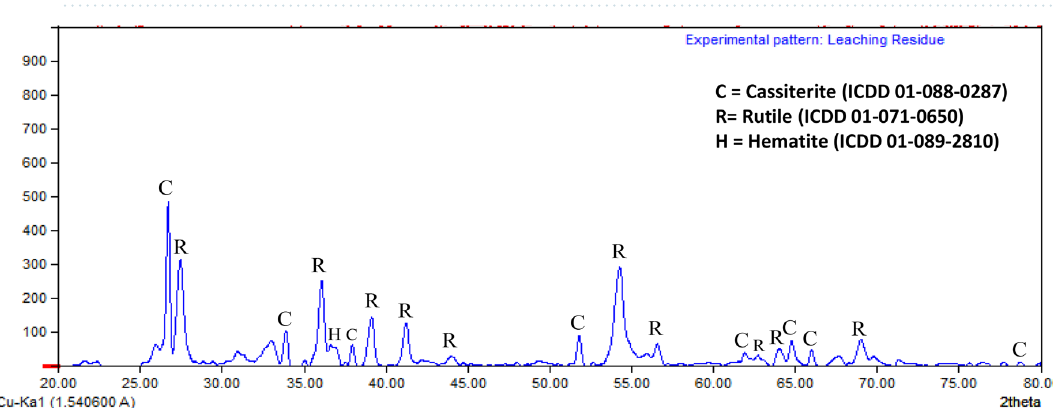
Figure 8. Morphological structures of ( a ) ilmenite; and ( b ) leaching residue.